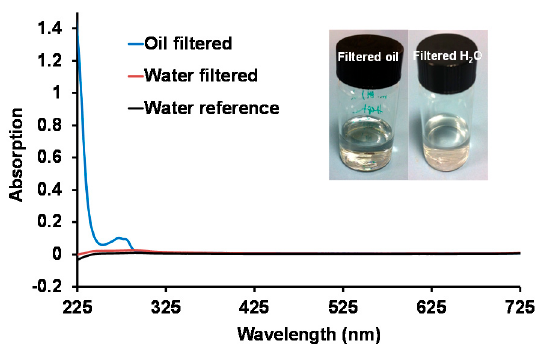
Figure 8. UV-vis absorption spectra of reference water (miliQ), filtered water and filtered oil.